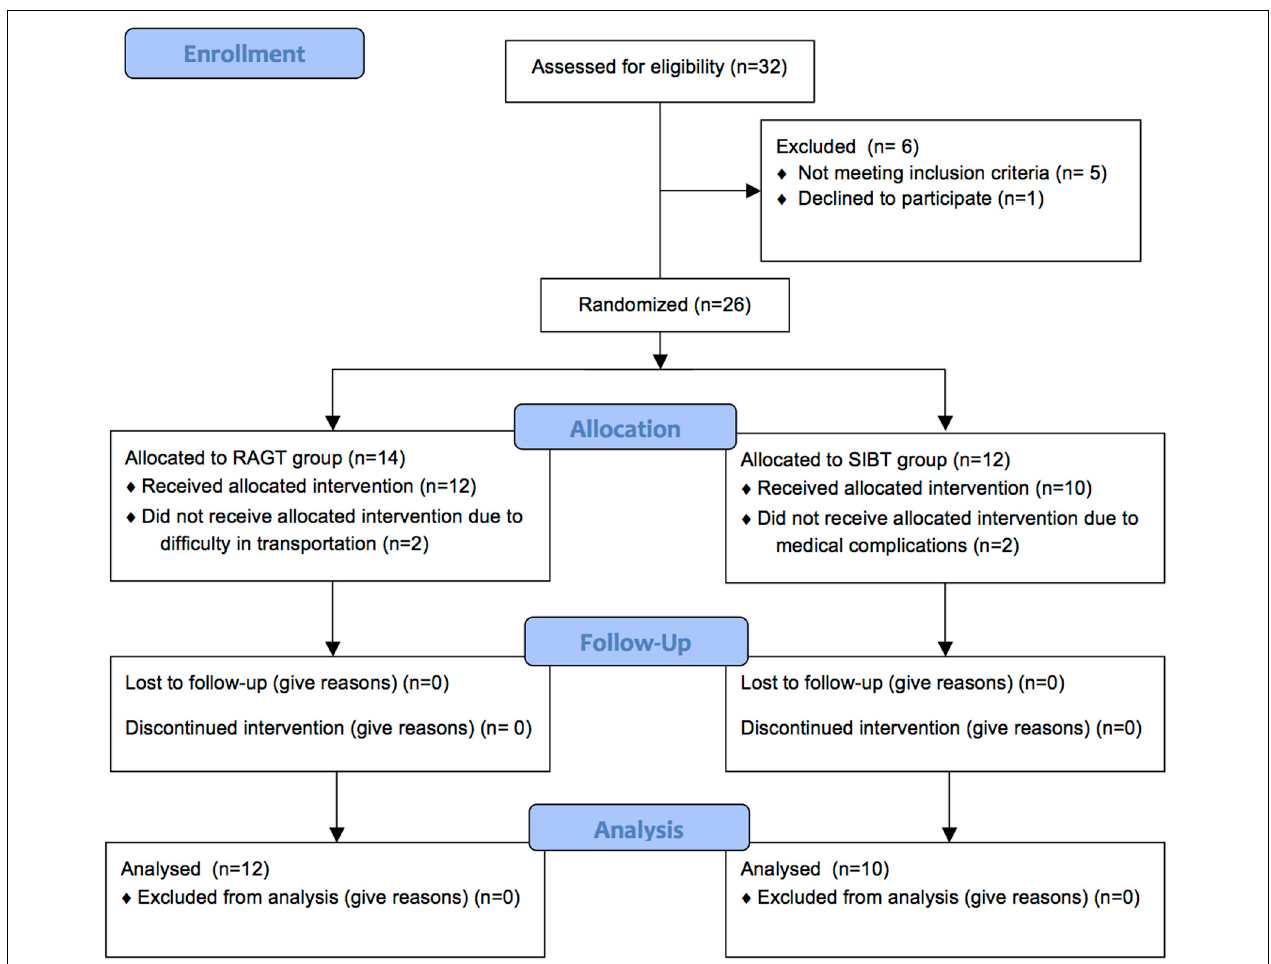
FIGURE 1 | Flow diagram of the